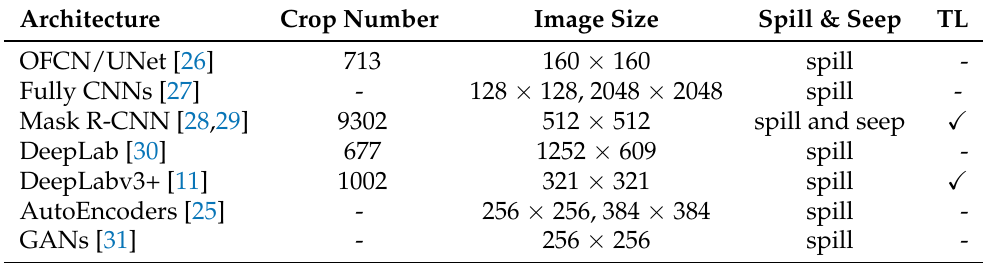
Table 2. Commonly used CNN models for oil slick detection.